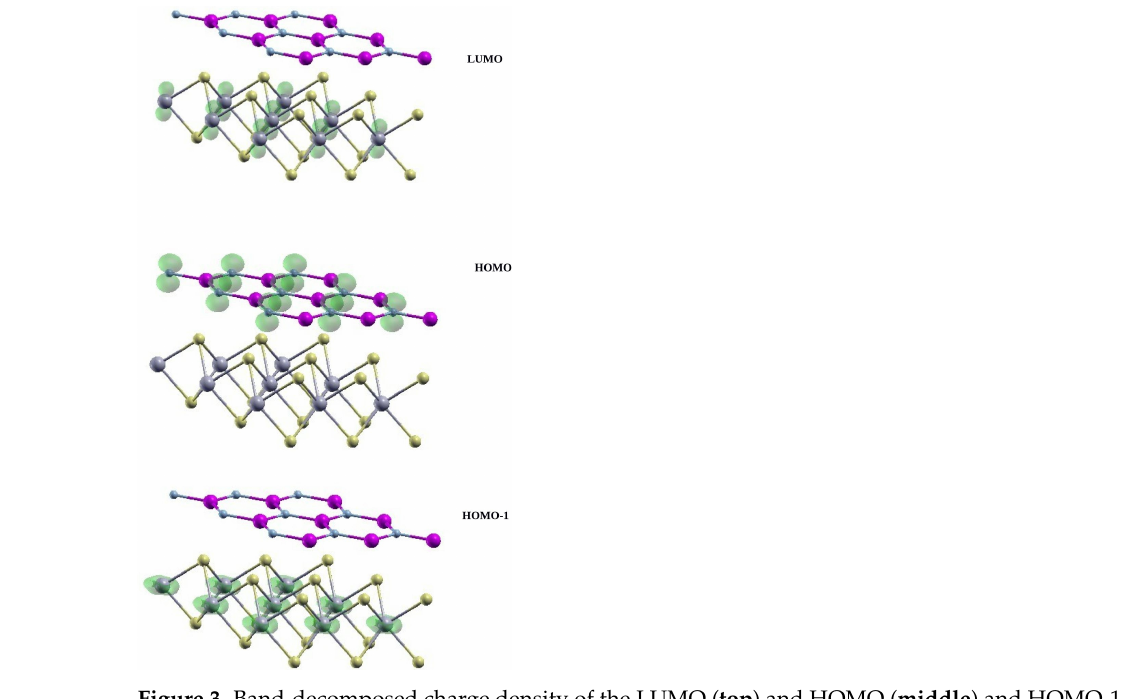
Figure 3. Band-decomposed charge density of the LUMO ( top ) and HOMO ( middle ) and HOMO-1 ( bottom ) at the DFT level for AlN / WS 2 vdW heterostructure at K point. The LUMO at Q , not reported in the figure, is very similar to the LUMO at K